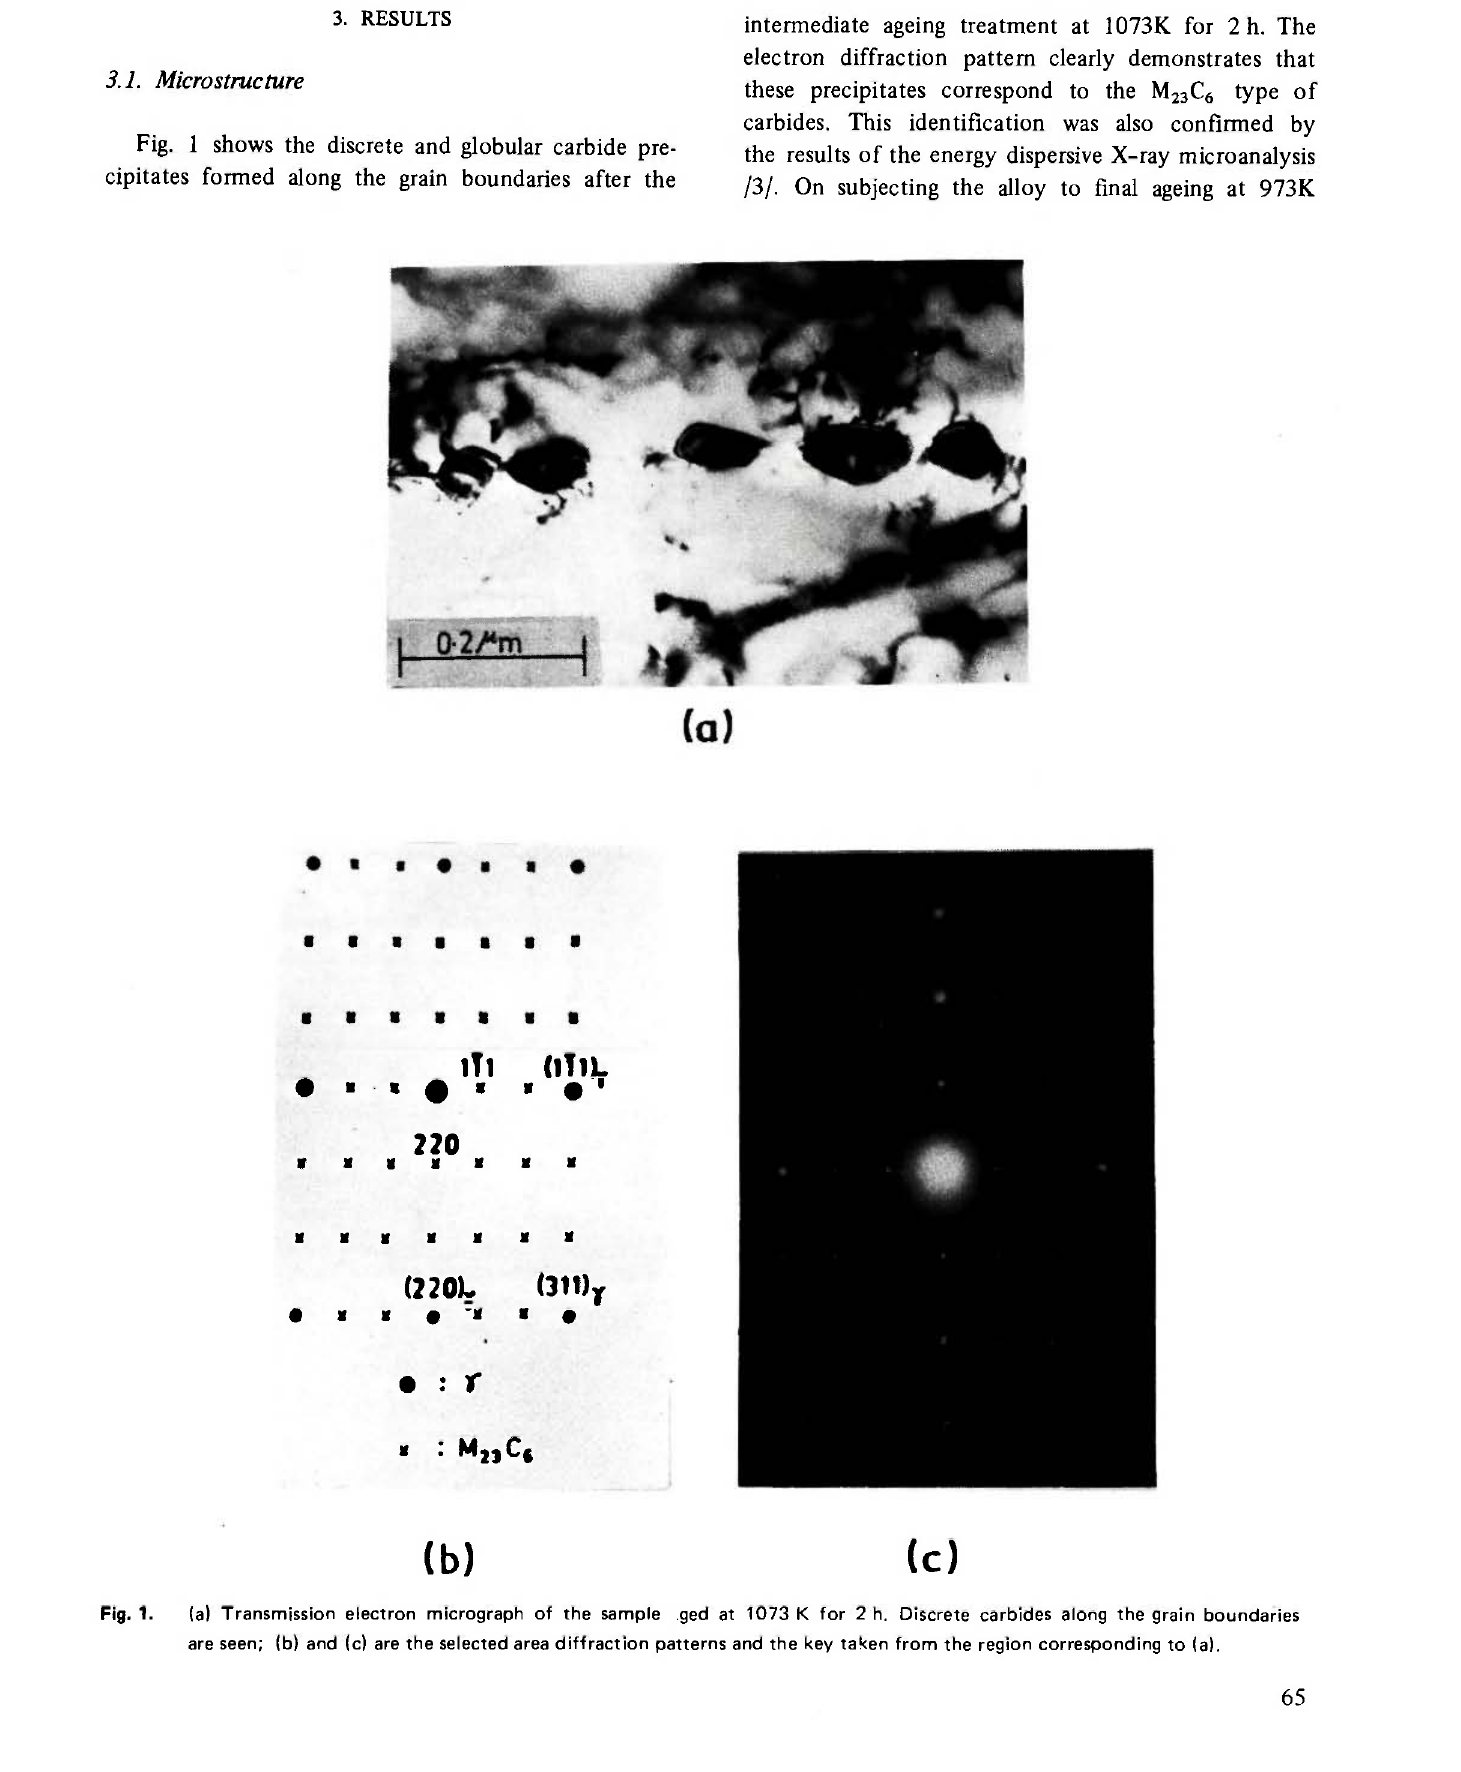
Fig. 1. (a) Transmission electron micrograph of the sample ged at 1073 Κ for 2 h. Discrete carbides along the grain boundaries are seen; (b) and (c) are the selected area diffraction patterns and the key taken from the region corresponding to